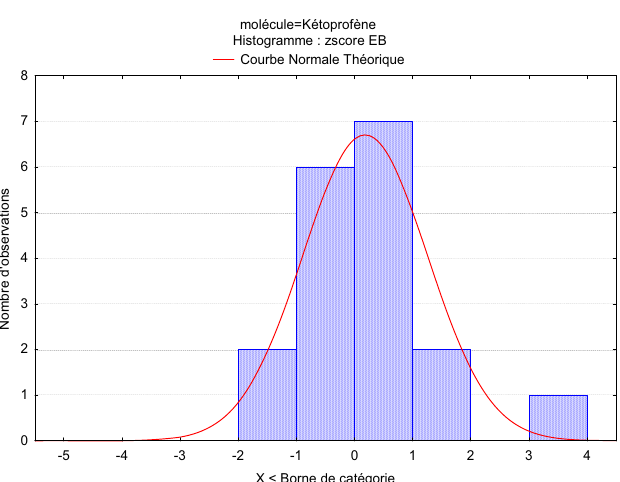
Fig. 1. Histogram of Z-scores for ketoprofen in raw water.